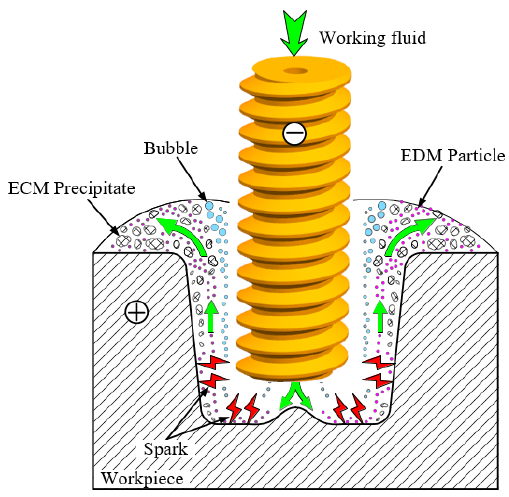
Figure 1. Principle of improvement of tube electrode high-speed electrochemical discharge machining (TSECDM) of holes by using helical tube electrode.